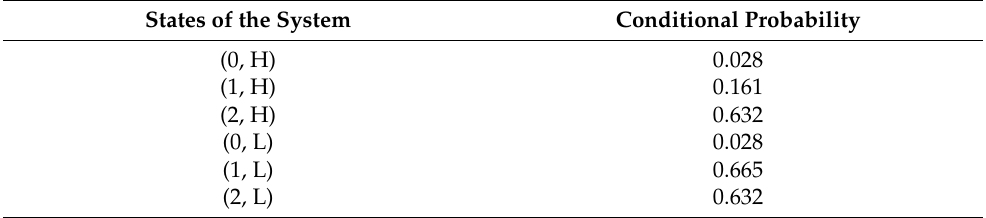
Table 13. Conditional probabilities of remaining in the same state within 1 period. States of the